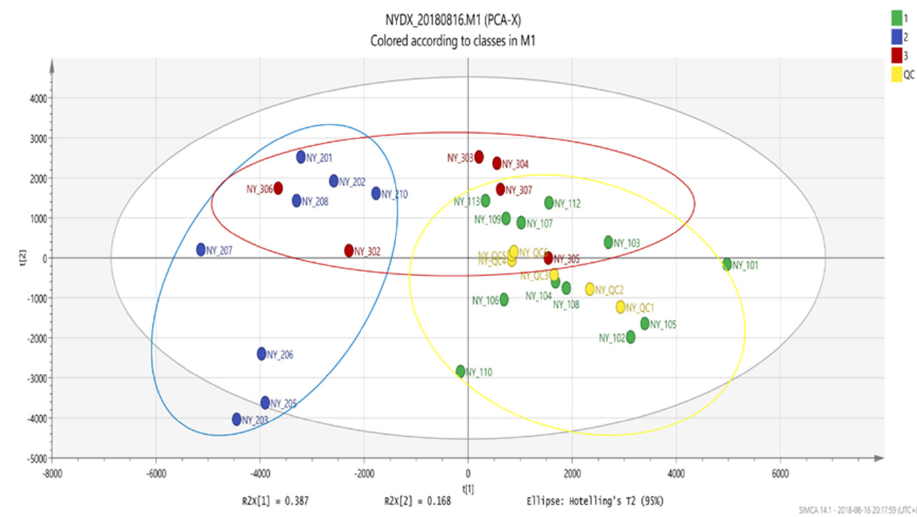
Figure 5. Score plot of PCA.